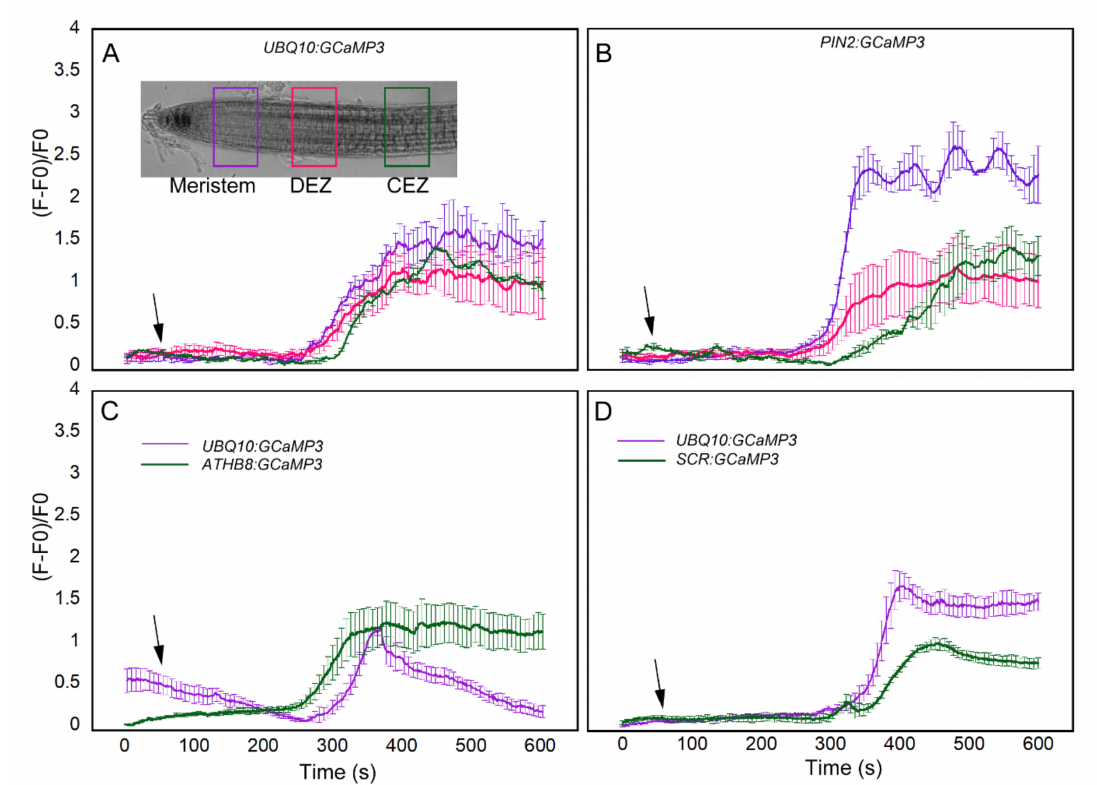
Figure 8. Direct comparison of ATP-induced [Ca 2 + ] cyt signatures in equivalent root developmental regions between UBQ10:GCaMP3 and cell-type specific GCaMP3 lines. Regions of interest (ROIs) were drawn in the meristem, distal elongation zone (DEZ), and central elongation zone (CEZ) in UBQ10:GCaMP3 ( A ) and PIN2:GCaMP3 ( B ) roots (inset in A). Comparison of ATP-induced [Ca 2 + ] cyt signatures in presumptive columella and endodermis of UBQ10:GCaMP3 lines with ATHB8:GCaMP3 ( C ) and SCR:GCaMP3 ( D ). Black arrows indicate the time of treatment. Plotted values represent the average normalized fluorescence intensity from 3-4 ROI per line with standard error bars every fifth time point. Fluorescence values were normalized to the lowest fluorescence